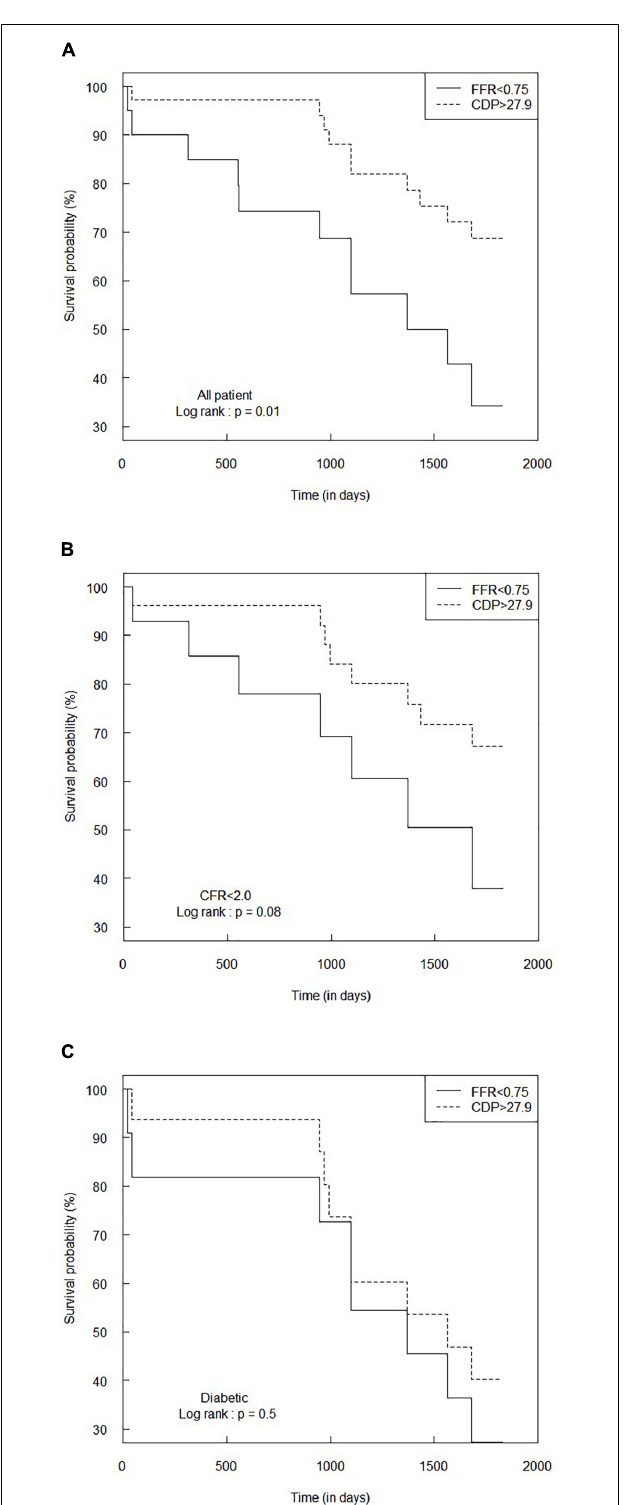
FIGURE 6 | Comparison of Kaplan–Meier survival curves between FFR < 0.80 and CDP > 25.4 groups for (A) the all-patient group, (B) CFR < 2.0 sub-group, and (C) diabetic sub-group. The p -values are provided for the log-rank test. CDP, pressure drop coefficient; FFR, fractional flow reserve.